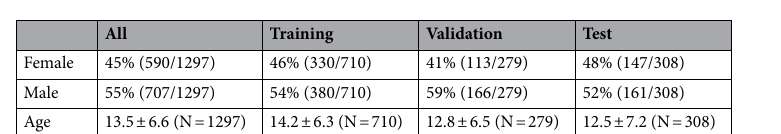
Table 1. Demographics of the patient collective. Age is reported in